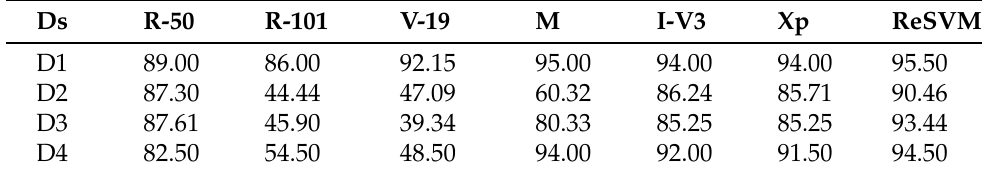
Table 2. Comparison of ReSVM in terms of accuracy with existing architectures on four datasets, namely: (i) State Farm Distracted Driver Detection, (ii) Boston University, (iii) DrivFace, and (iv) FT- UMT datasets. DS = Dataset, D1 = SFDDD, D2 = BU, D3 = DrivFace, D4 = FT-UMT, R-50 = ResNet-50,